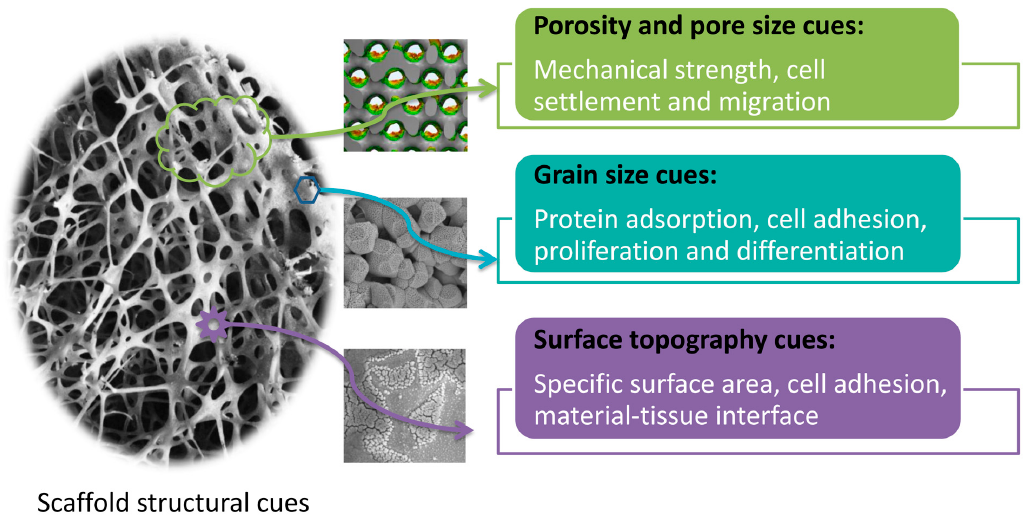
Figure 2. The biofunctions of scaffold structural microenvironmental cues.